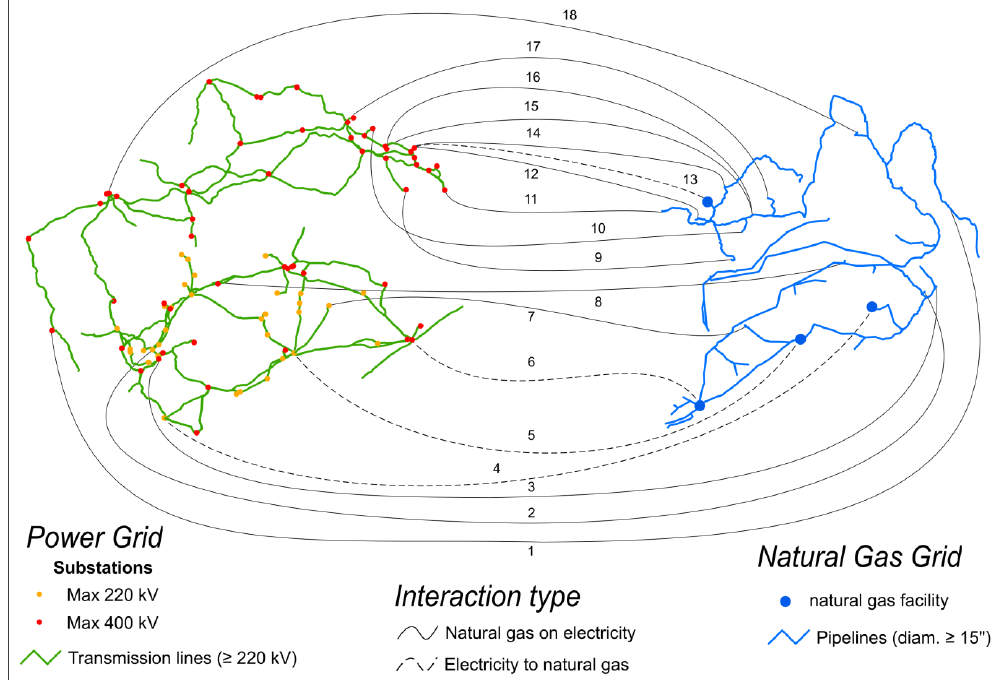
Figure 4. Integrated gas and power network applied in the case study. Map shows a real network of an European region, which has been disguised due to confidentiality reasons. The network data and properties used for the case studies, however, are original input data for the actual network. The solid black lines (lines 1–3, 7–12, 14–18) represent interconnections between Gas Fired Power Plants (GFPPs) in the power grid ( left ) and their fuel gas offtake points in the gas grid ( right ), while the dashed black lines (4–6, 13) represent interconnections between electric buses in the power grid ( left ) supplying electric power to connected facilities in the gas